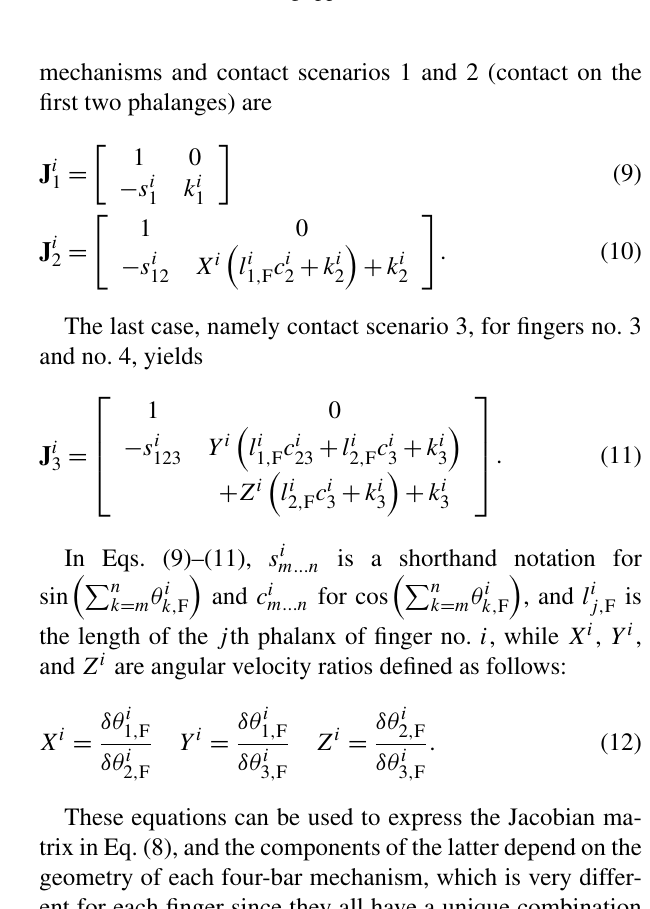
Figure 4. Simulation of a closing sequence of a geometry of finger no. 1 mounted on a translational